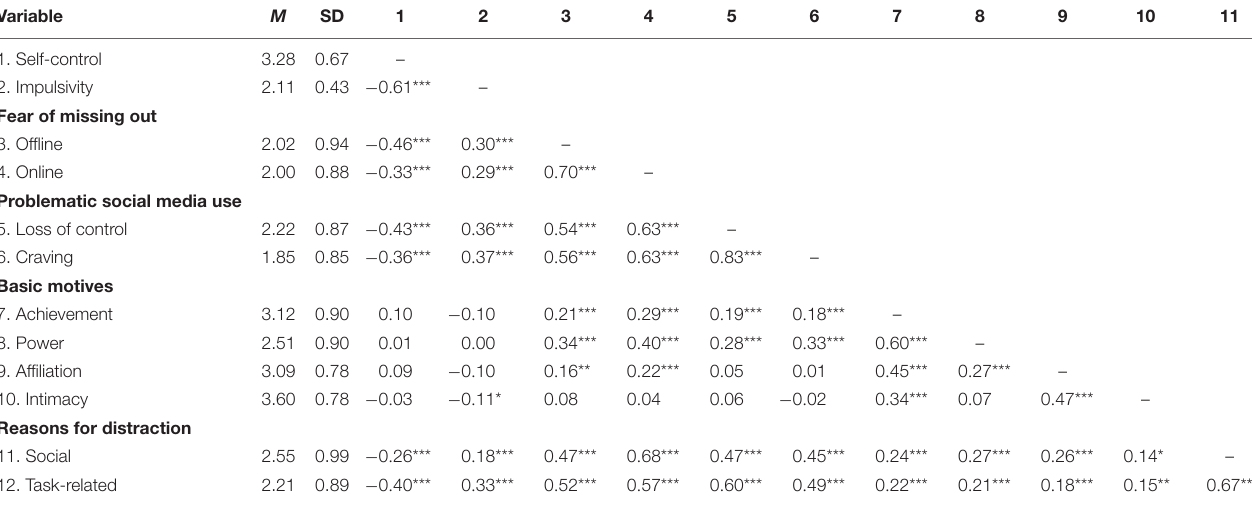
TABLE 6 | Descriptive statistics and correlations for reasons for distraction and traits. Variable